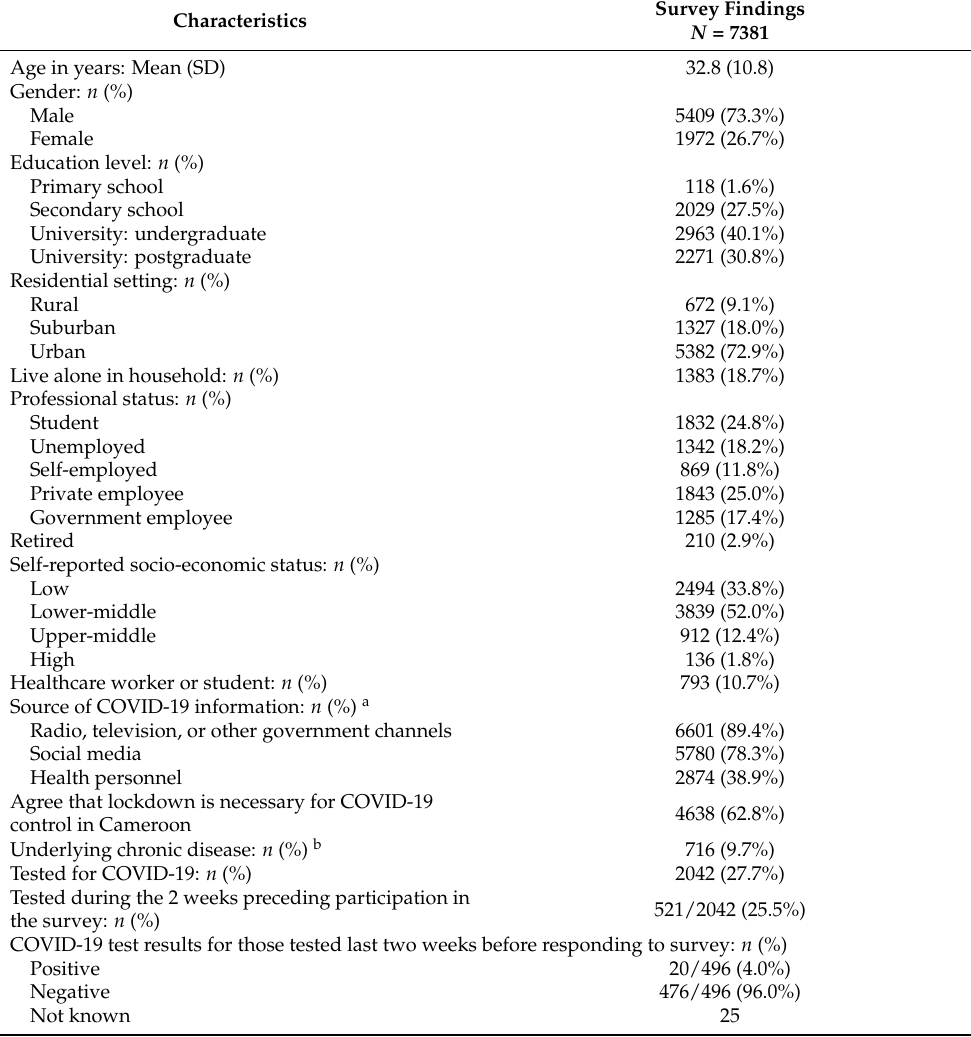
Table 1. Socio-demographic characteristics of